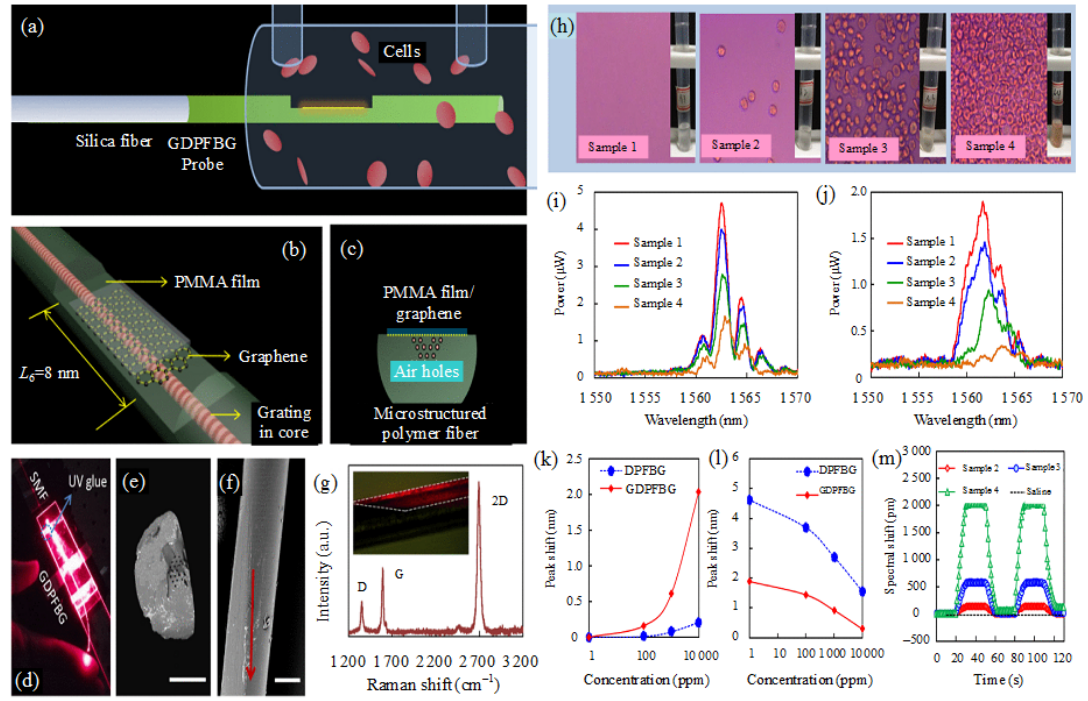
Fig. 5 Schematic diagram of the graphene-based D-shaped polymer FBG (GDPFBG) probe and its experimental results for RBC concentration sensing